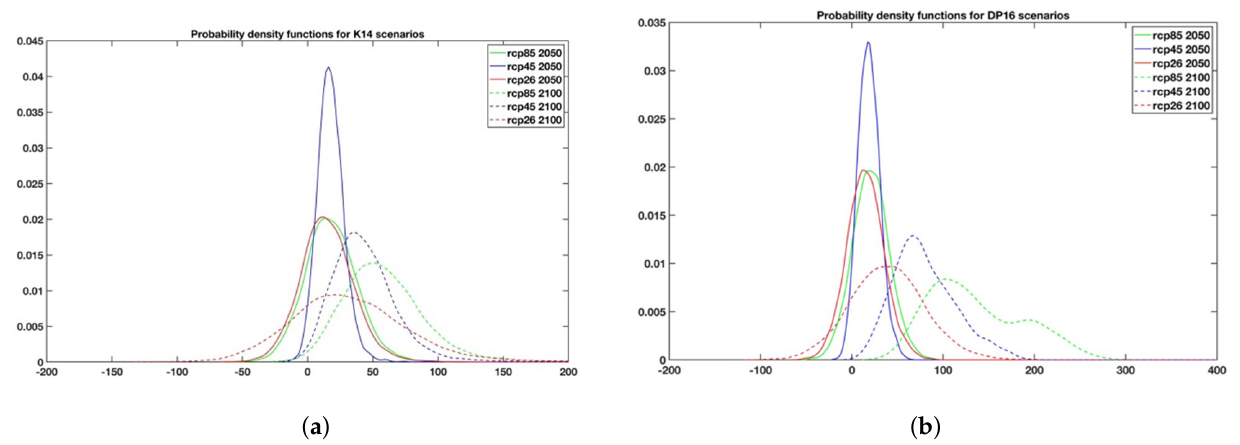
Figure 10. Probability density functions at the year 2050 and 2100 for each RCPs, for the sea level rise scenario K14 ( a ) and Dp16 ( b )